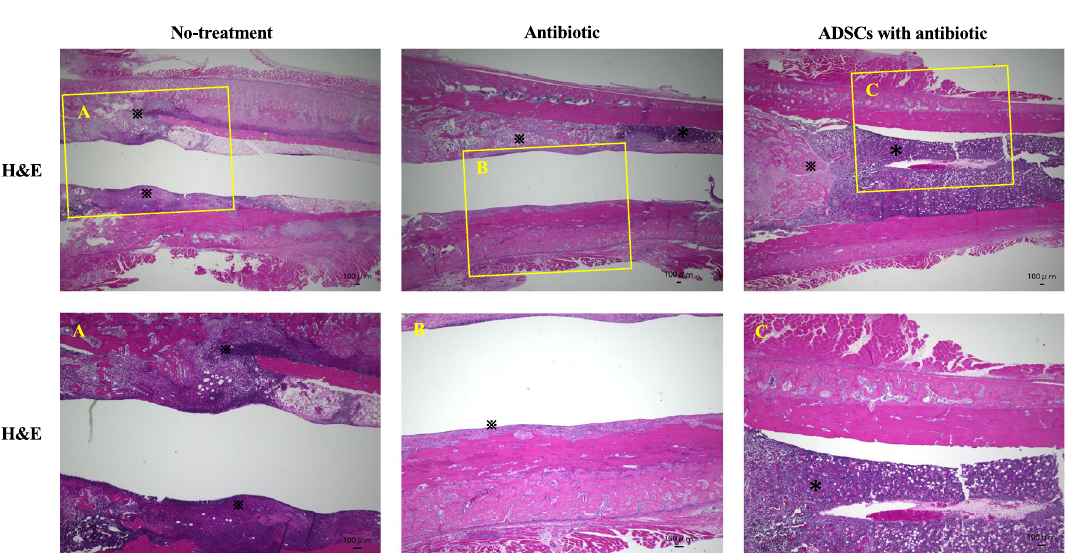
Figure 6. Histologic analysis. Representative photomicrographs of histologic sections (1 of the 6 rats per group, with similar results). Low and high magnification of H&E-stained joint specimens. The H&E-stained histology sections taken from the transverse plane across the implant revealed a clear, thin, and continuous bony envelope and homogeneous bone marrow as well as a defined normal interface between these structures in the ADSCs with antibiotic group. ( A ), ( B ), and ( C ) represent high-magnification images of the boxed regions. ※ abscess formation, *bone marrow. H&E hematoxylin and eosin, ADSC adipose-derived mesenchymal stem